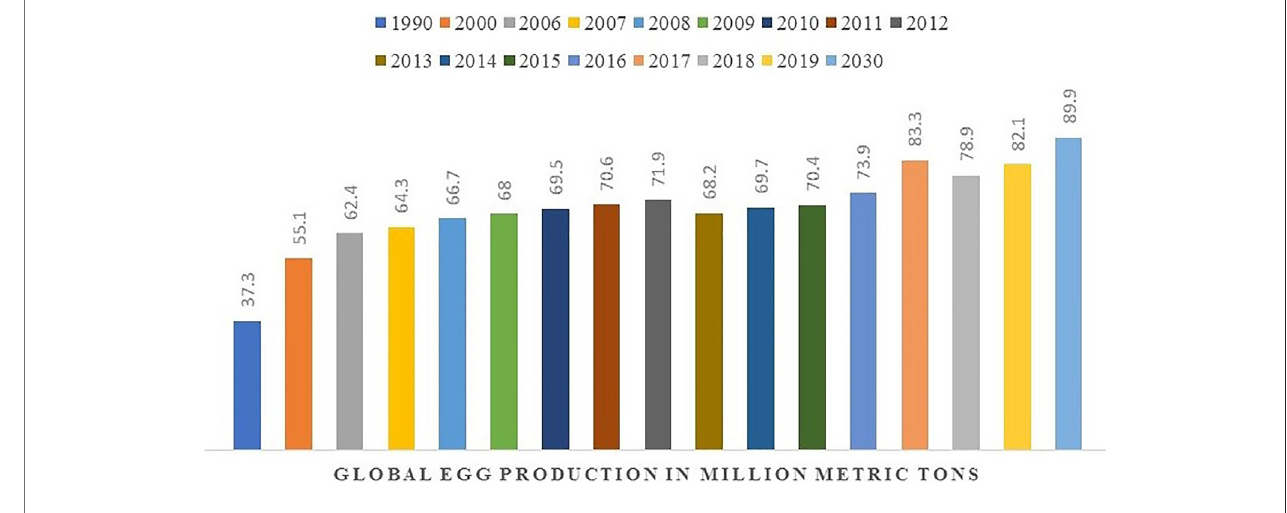
FIGURE 1 | Global egg production rate with expected.